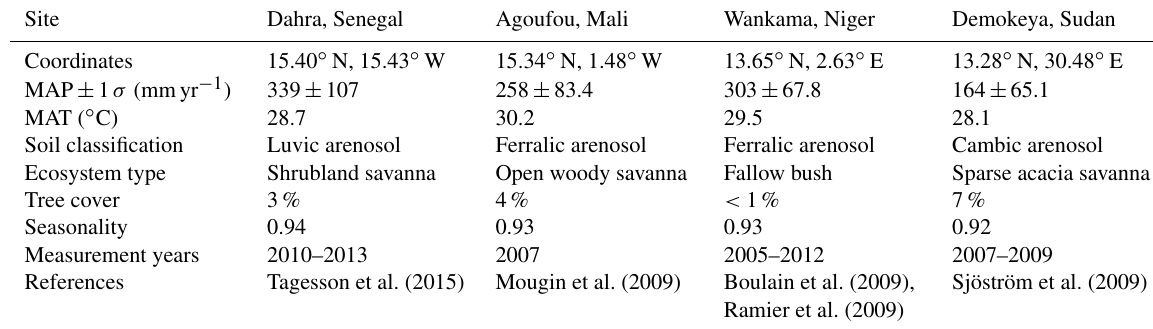
Table 1. Overview of the different flux tower sites used in this study, together with the 1979–2016 mean annual precipitation and its standard deviation (MAP, mmyr − 1 ) from the Multi-Source Weighted-Ensemble Precipitation (MSWEP) v1.2 dataset (Beck et al., 2017), mean annual temperature (MAT, ◦ C) from the WFDEI (WATCH – WATer and global CHange – Forcing Data methodology applied to ERA-Interim) dataset (Weedon et al., 2014), FAO (Food and Agriculture Organization) soil classification (FAO, 1988), ecosystem type and tree cover (Tagesson et al., 2016), rainfall seasonality (fraction of rainfall inside the rainy season), measurement years (eddy covariance data available for model validation), and literature reference.